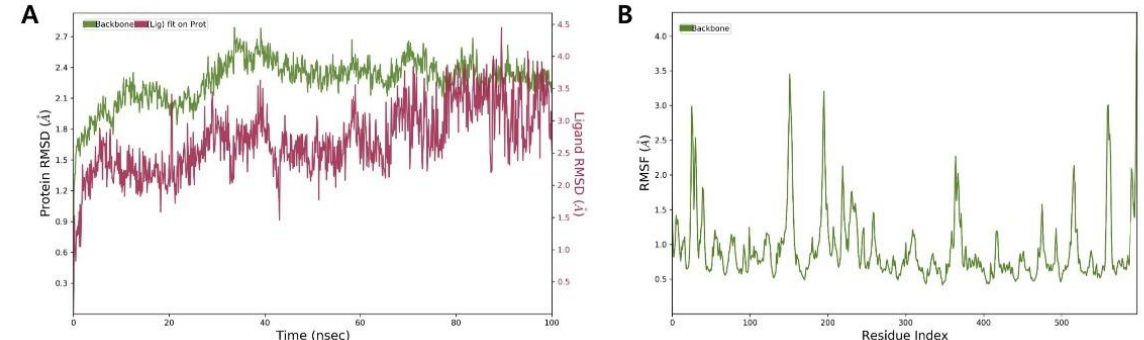
Figure 6. Molecular dynamics simulation of active compound 1 and β -glucuronidase (PDB ID: 6LEL) complex: RMSD (( A ), protein RMSD: green line and RMSD of 1 : red line) and RMSF ( B ).